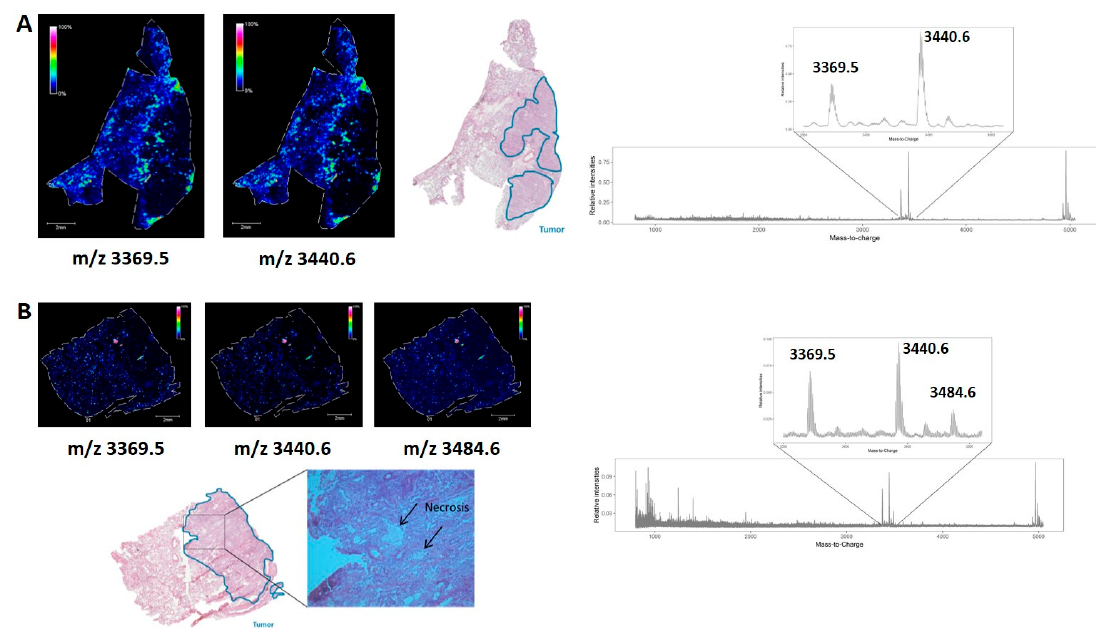
Figure 1. Distribution of the peptides of interest in fresh frozen non-small cell lung cancer (NSCLC) tissues, obtained with matrix-assisted laser desorption/ionization (MALDI) mass spectrometry imaging. ( A ) In this example of human squamous cell carcinoma lung cancerous tissue with adjacent reference tissue, the interesting peptides are expressed in the nontumor region, highly expressed at the interaction border between the nontumor and the tumor region and a low to no expression deeper in the tumor region; ( B ) In this example of human adenocarcinoma lung cancerous tissue with adjacent reference tissue, these peptides are also expressed in necrotic regions within the tumor region. These regions were confirmed in the corresponding hematoxylin and eosin (H&E) staining, and performed after the matrix-assisted laser desorption/ionization mass spectrometry imaging (MALDI MSI) experiment on the same tissue section. The overall average mass spectrum of the whole tissue section obtained after MALDI MSI, which is zoomed out at the peptides of interest m / z 3369.5, m / z 3440.6 (and m / z 3484.6), is displayed, of which the corresponding distribution is portrayed in the left part of the figure.